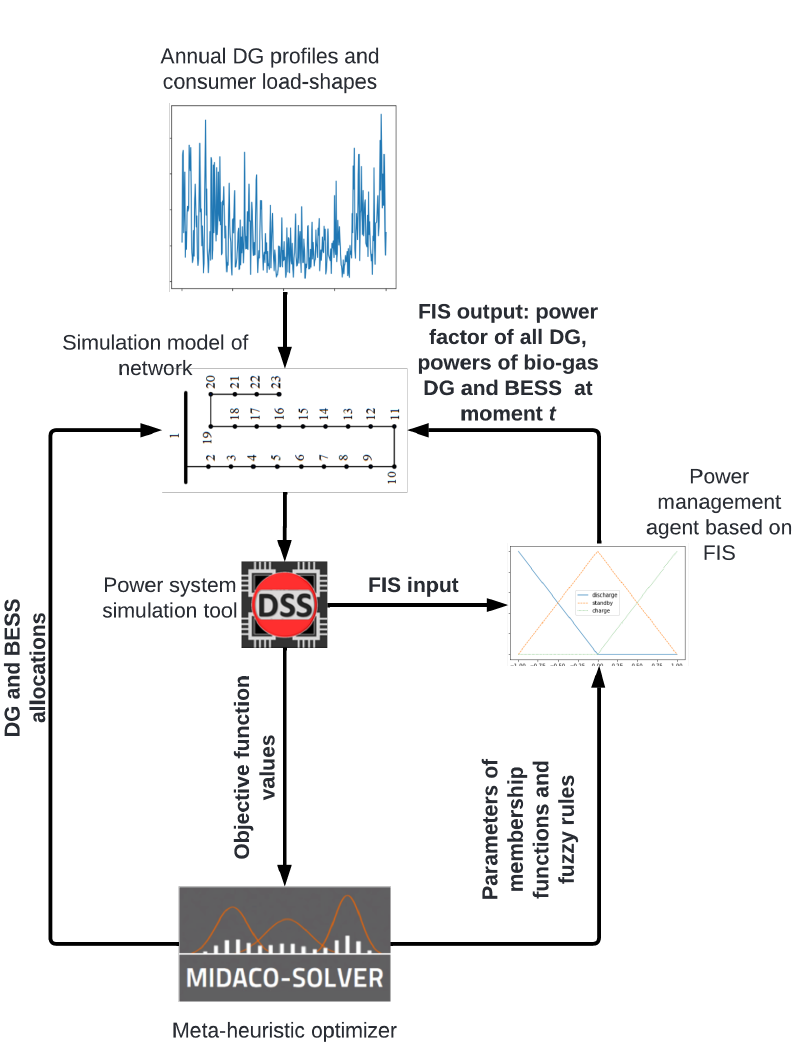
Figure 2. Proposed optimization setup based on co-simulation